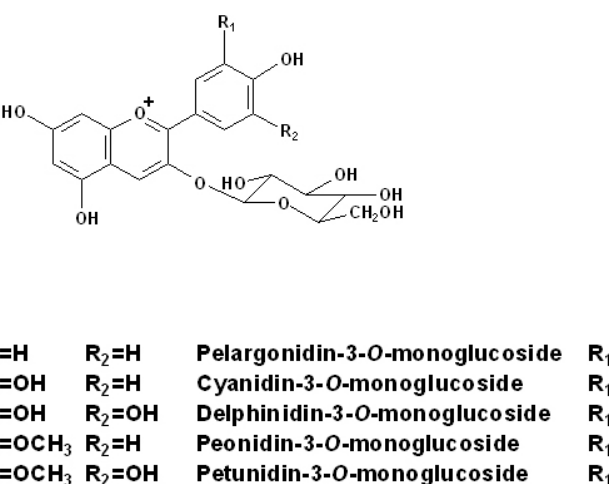
Figure 1. Structures of the individual anthocyanins in grapes